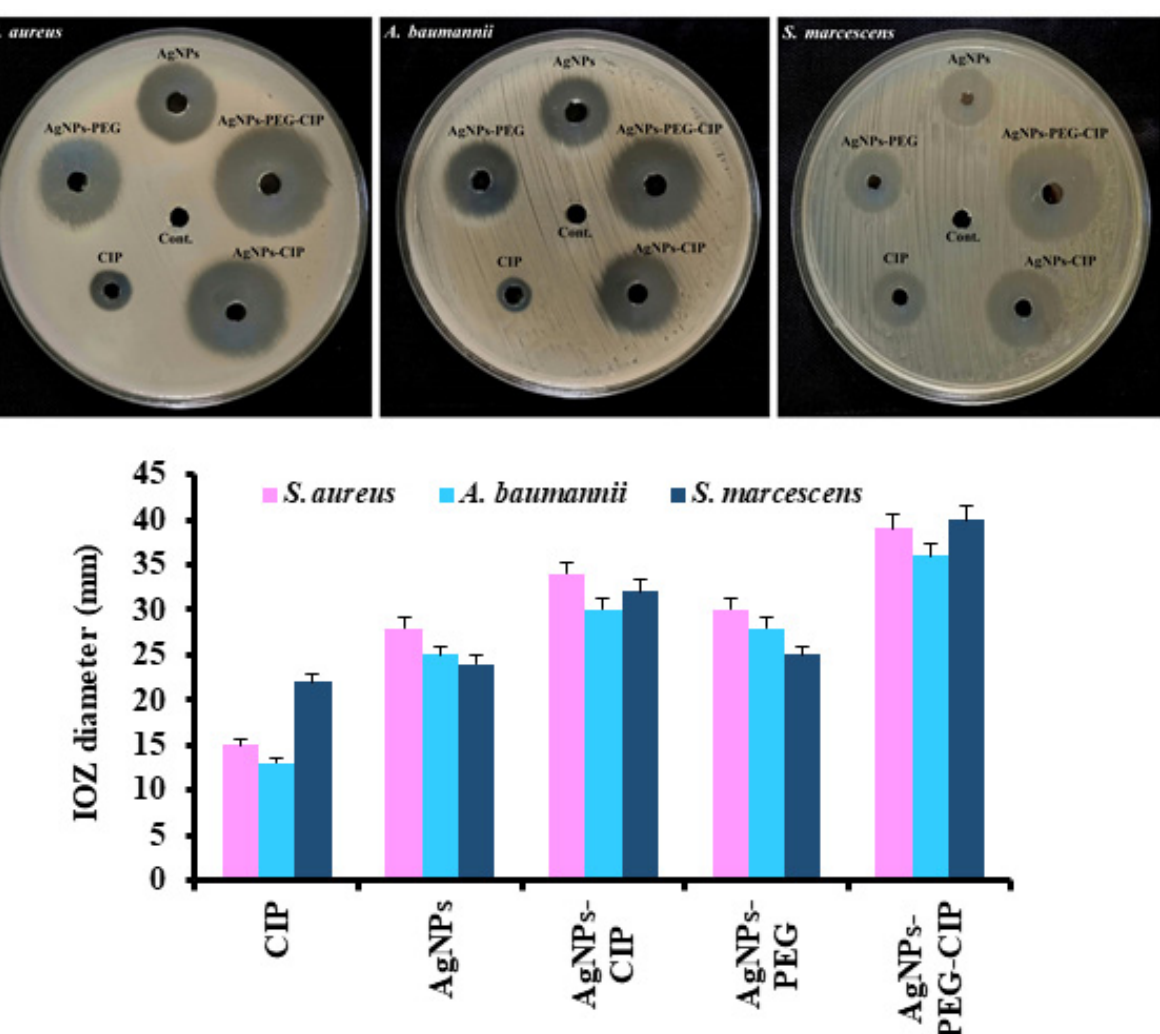
Figure 13. The synergistic effects of the AgNPs-PEG, AgNPs-CIP, and AgNPs-PEG-CIP on the growth of pathogenic bacteria, compared to CIP and to AgNPs alone.